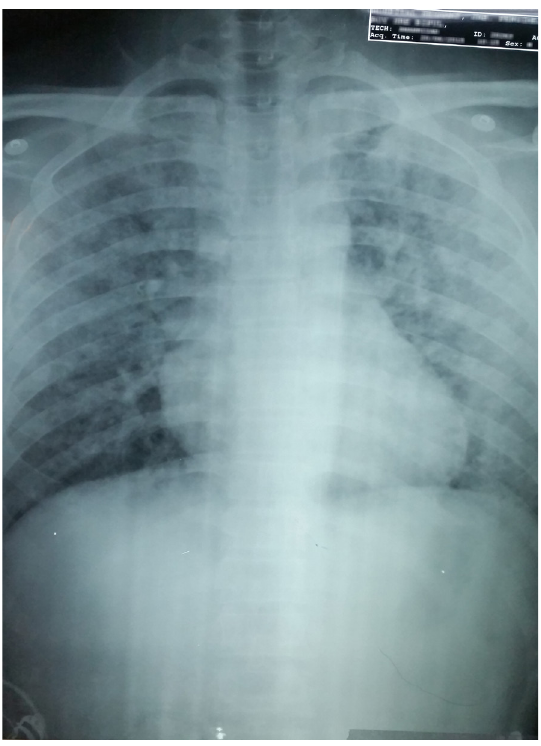
Figure 1. A posterior-anterior (PA) view of the patient’s chest radiograph on admission showing gross alveolar shadowing, suggestive of intra-alveolar hemorrhage.